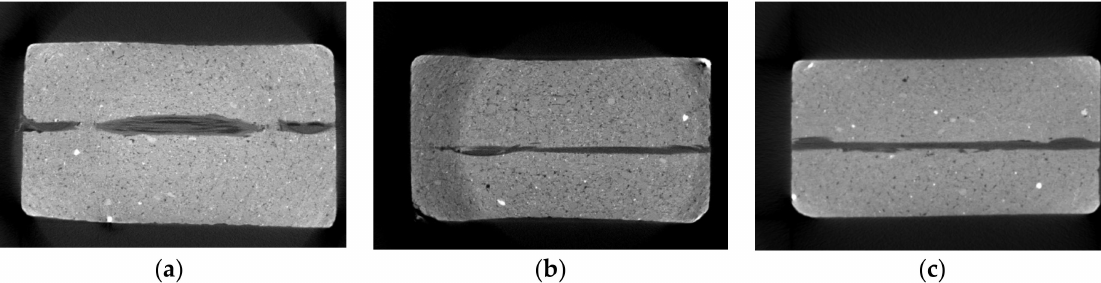
Figure 14. ( a ) CT scan of carbon textile with Mortar 1, ( b ) CT scan of carbon textile with Mortar 2, ( c ) CT scan of carbon textile with Mortar 3.